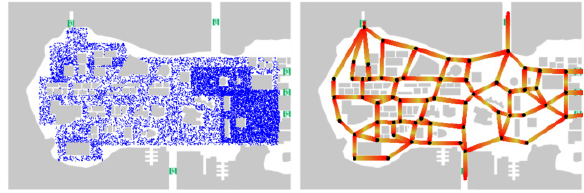
Fig. 10 Left: distribution of agents on the island. Right: road map.